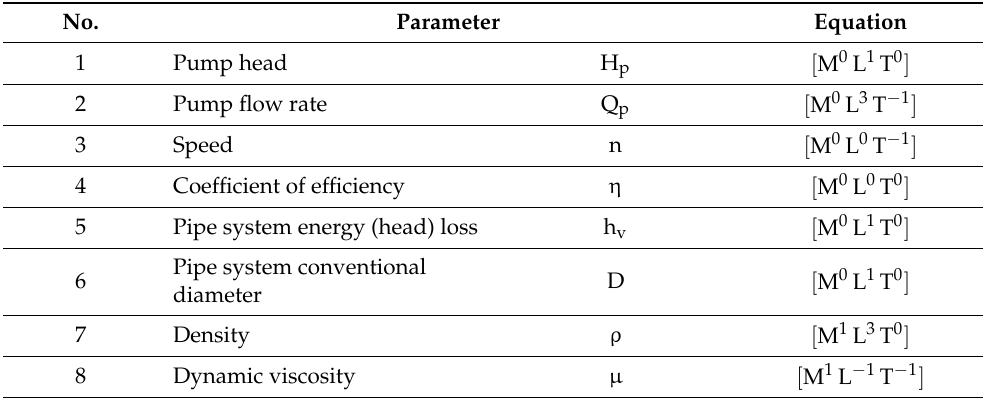
Table 1. Basic information concerning the used operating